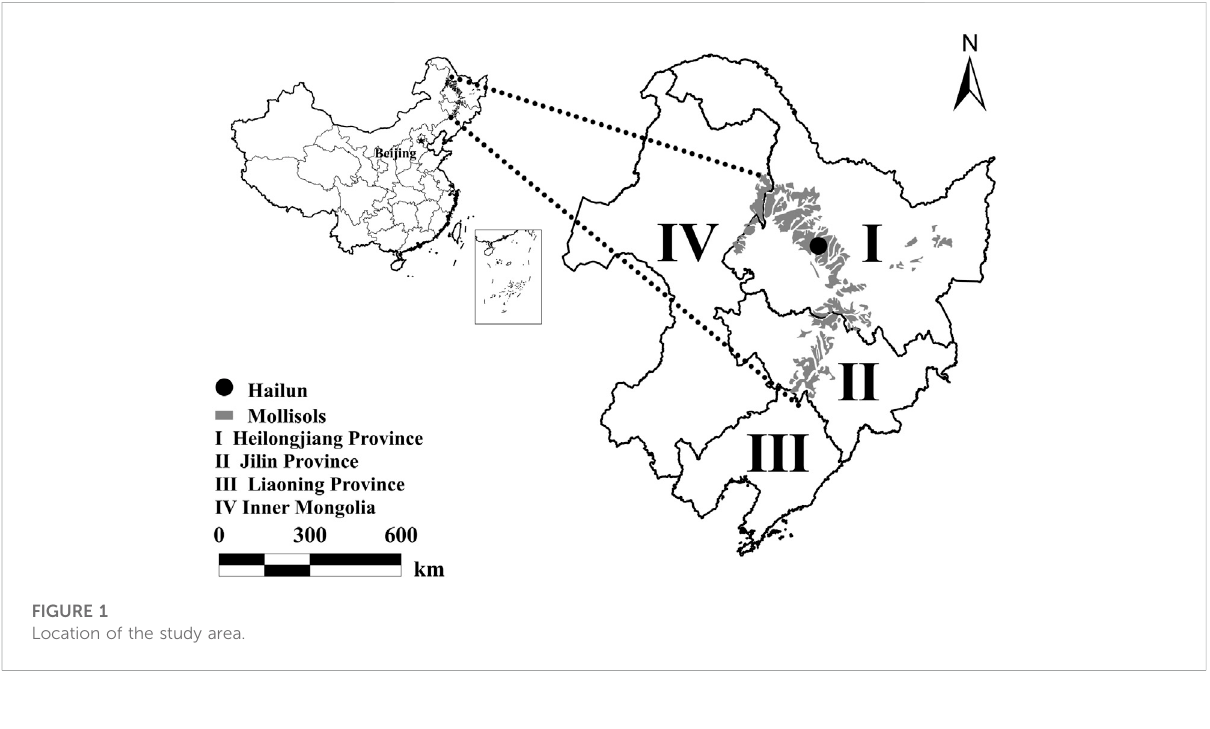
FIGURE 1 Location of the study area.